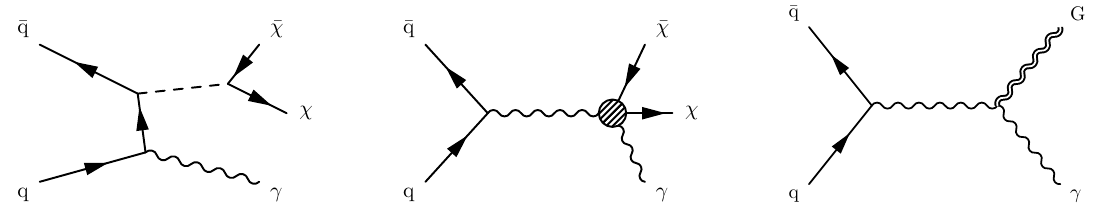
Figure 1 . Leading-order diagrams of the simpli(cid:12)ed DM model (left), electroweak-DM e(cid:11)ective interaction (center), and graviton (G) production in the ADD model (right), with a (cid:12)nal state of (cid:13) and large p miss T